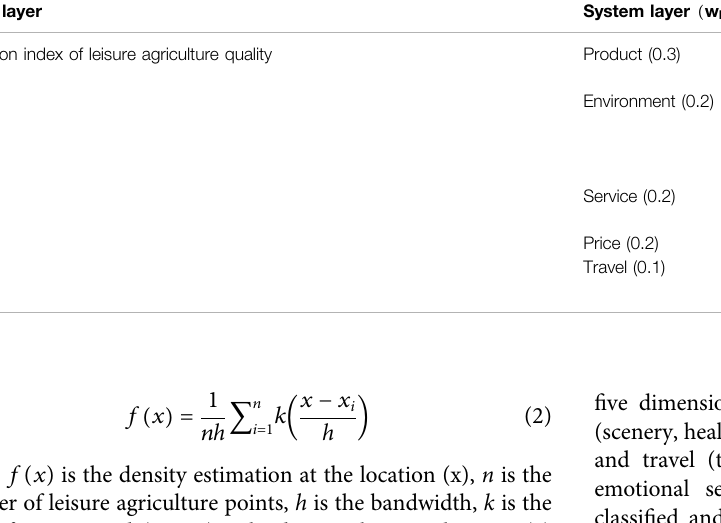
TABLE 1 | Evaluation index of leisure agriculture quality. Target